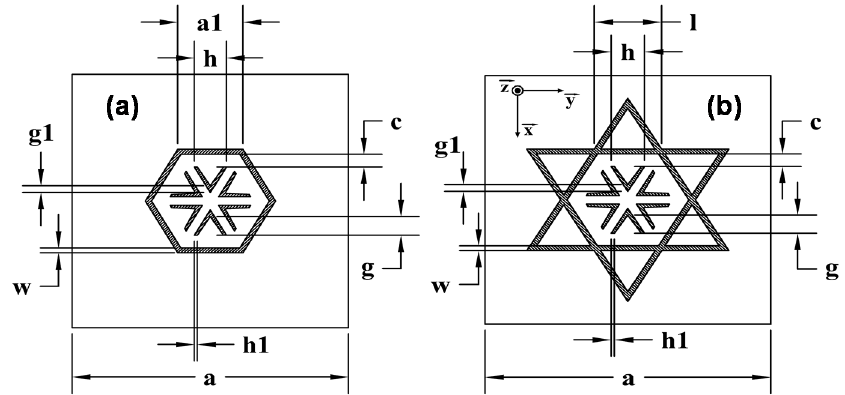
Figure 1. Unit-cell geometries: ( a ) hexagon and ( b )